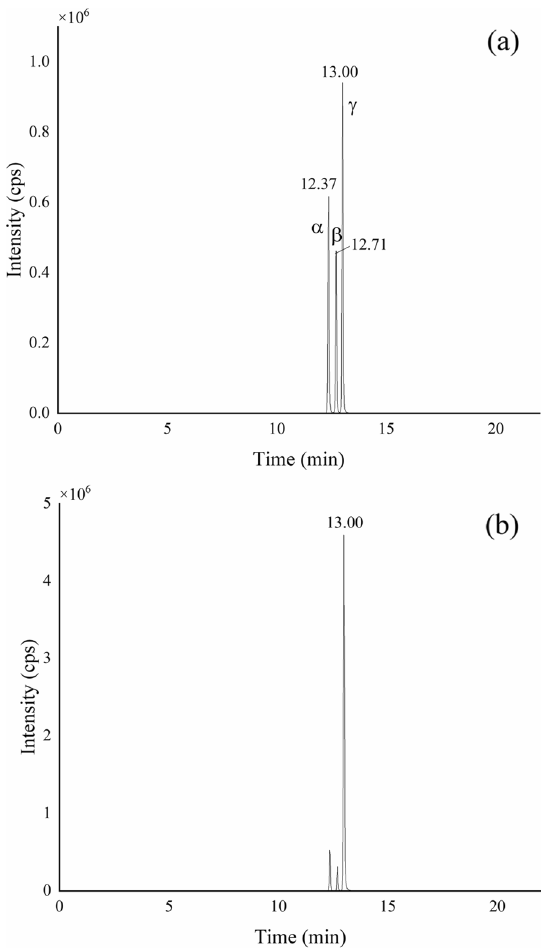
Fig. 1 a 25 ng mL − 1 standard mixtures b the soil sample with the greatest HBCD